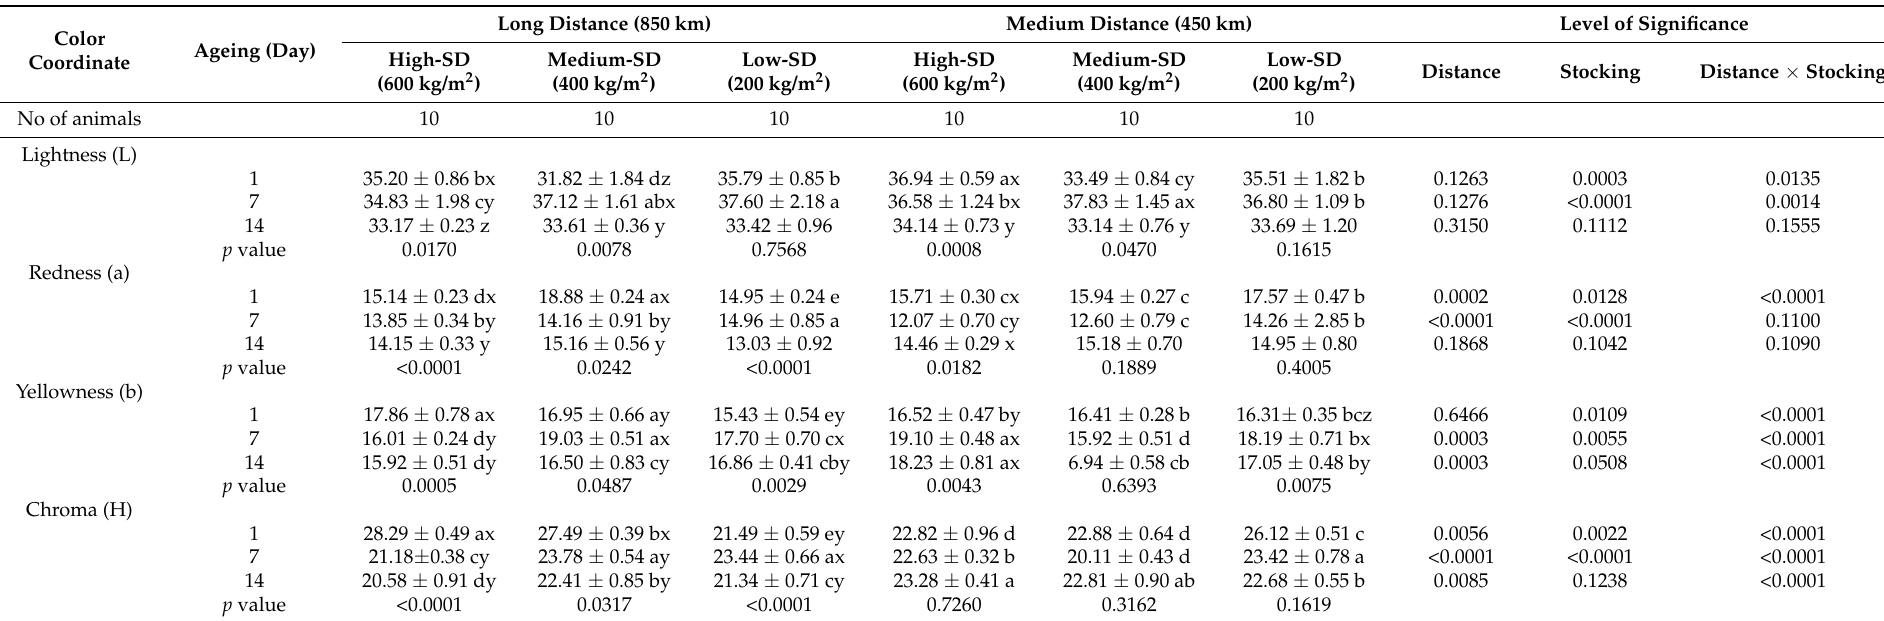
Table 1. Differences in color coordinates of Longissimus lumborum muscle during postmortem ageing periods in cattle subjected to different distances and stocking densities (SD) during road